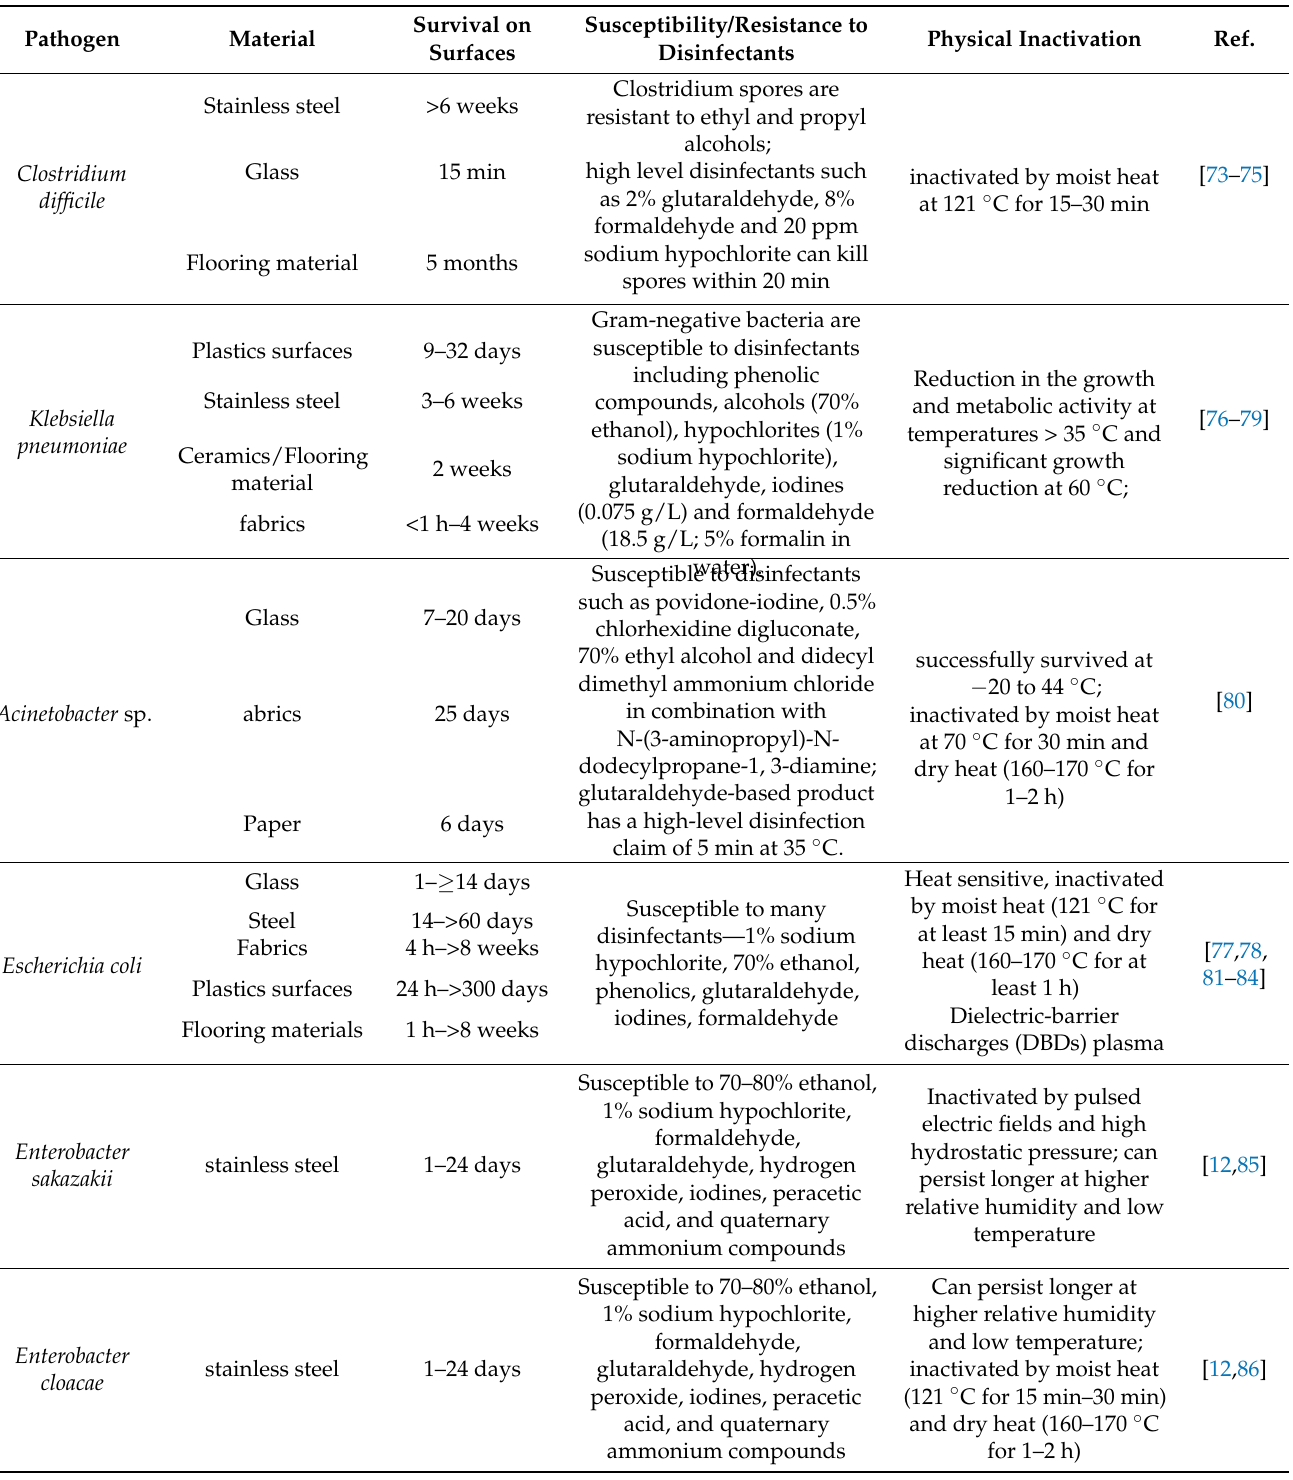
Table 1. Selected bacterial strain survival on inanimate surfaces and their resistance to